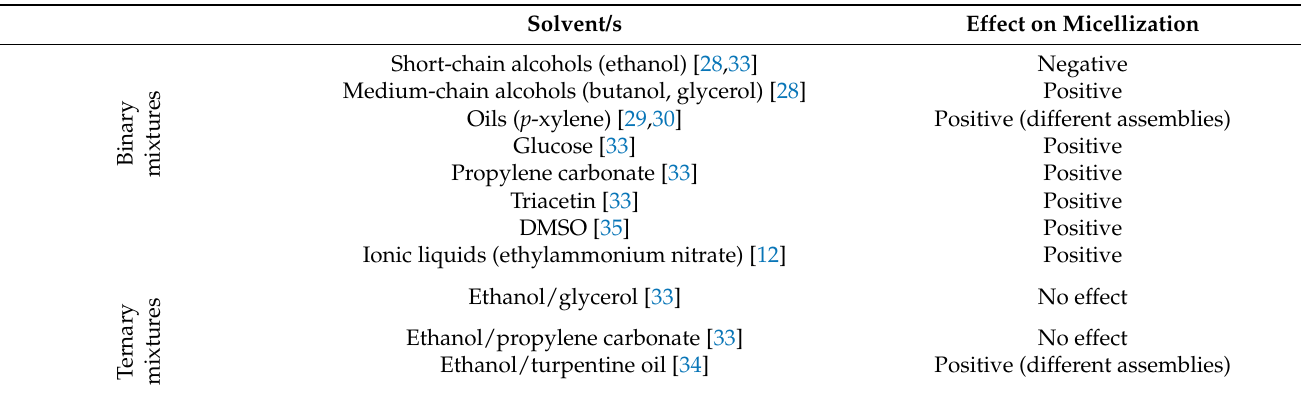
Table 2. Summary of effects of different solvents on Pluronic micellization. Positive: favors the formation of micelles. Negative: disfavors the formation of micelles. All mixtures employ water as main